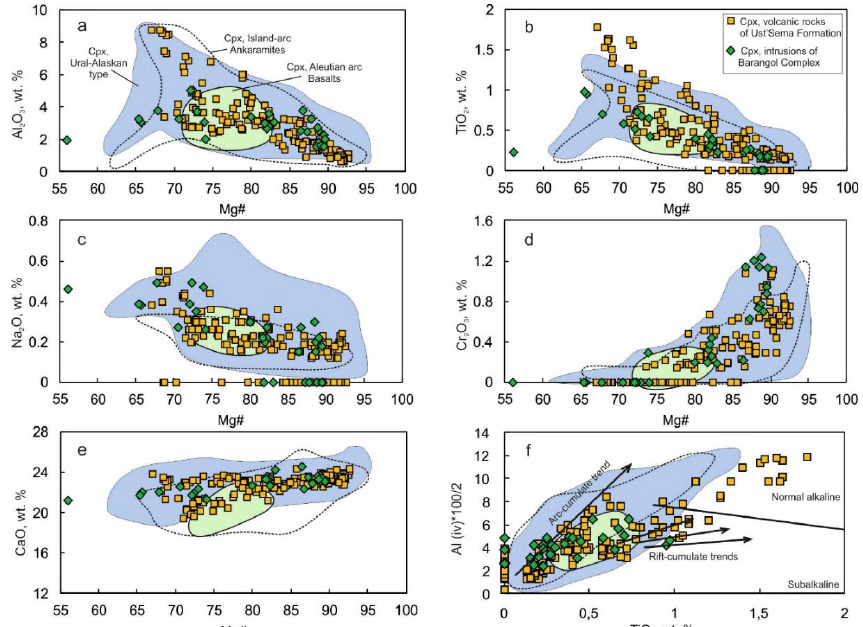
Figure 12. Variations in the composition of clinopyroxene from the rocks of the Ust’-Sema Formation and the Barangol Complex compared with clinopyroxene from island arc ankaramites [33 – 36], Ural – Alaskan-type intrusions [39,41,42], and basalts of the Aleutian arc [44,45]. ( a ) Mg# vs. Al 2 O 3 ; ( b ) Mg# vs. TiO 2 ; ( c ) Mg# vs. Na 2 O; ( d ) Mg# vs. Cr 2 O 3 ; ( e ) Mg# vs. CaO ( f ) TiO 2 vs. Al iv *100/2. The boundaries of the fields from [46] and the trends from [47].